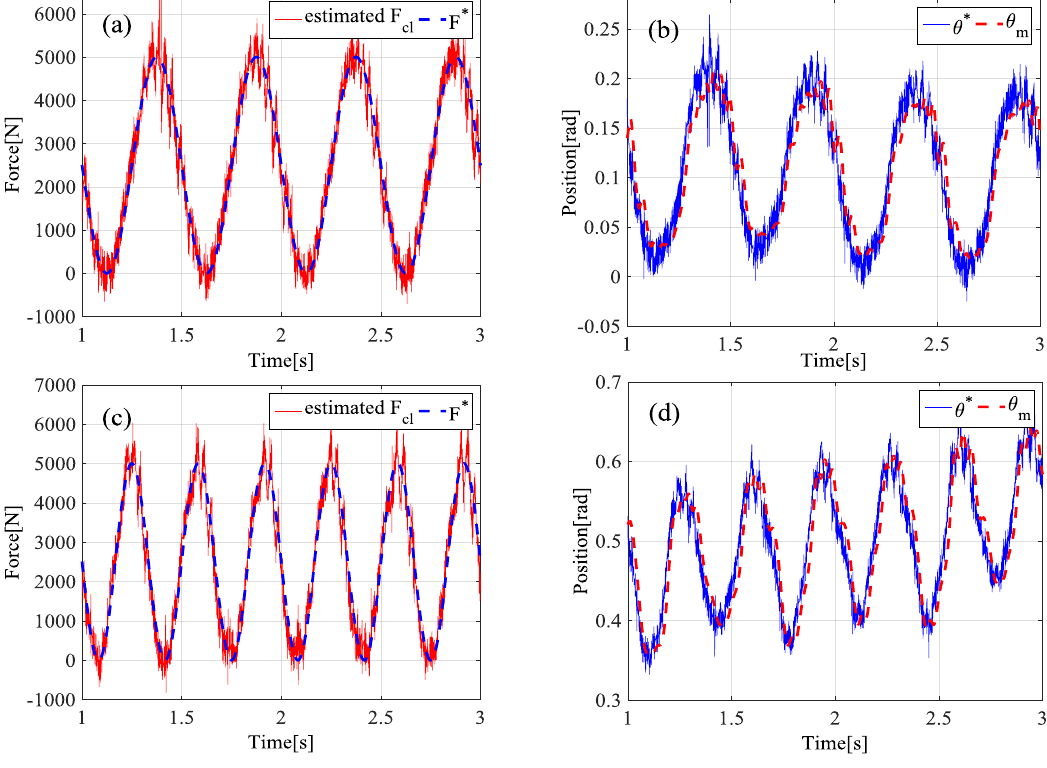
Figure 12. Experimental results for braking force apply and release mode: ( a ) A result for the clamping force tracking control with the 2 Hz force command; ( b ) A result for the position tracking control with the 2 Hz force command; ( c ) A result for the clamping force tracking control with the 3 Hz force command; ( d ) A result for the position tracking control with the 3 Hz force command.